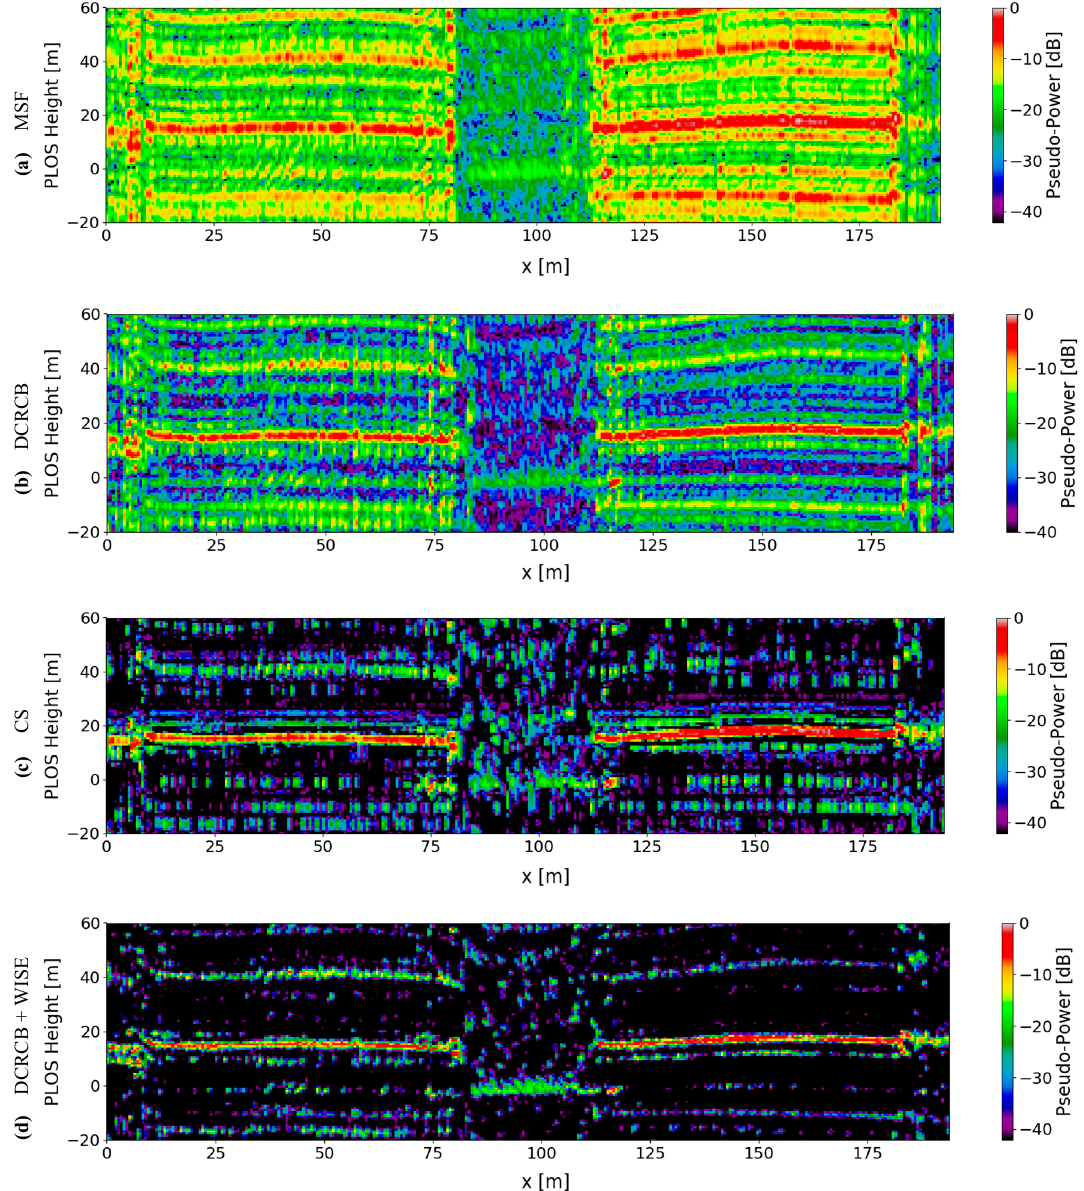
Figure 11. HH tomograms retrieved from the area depicted by the green line crossing the ROI specified in Figure 5. We perform focusing using ( a ) MSF, ( b ) DCRCB, ( c ) CS and ( d ) DCRCB + WISE. We refer to the single-look case. All tomograms are normalized with respect to the (pseudo) power recovered by MSF.